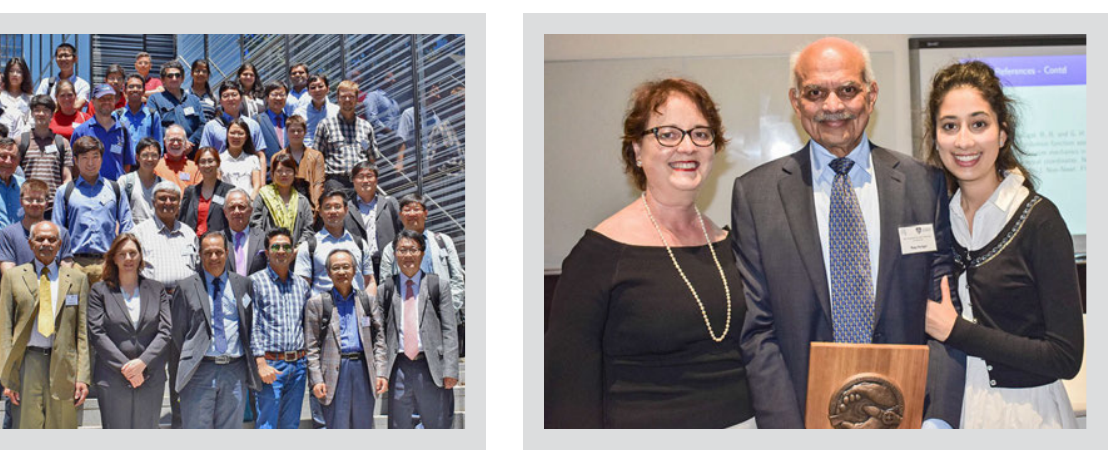
DOI: 10.1515/arh-20 18 -00 0